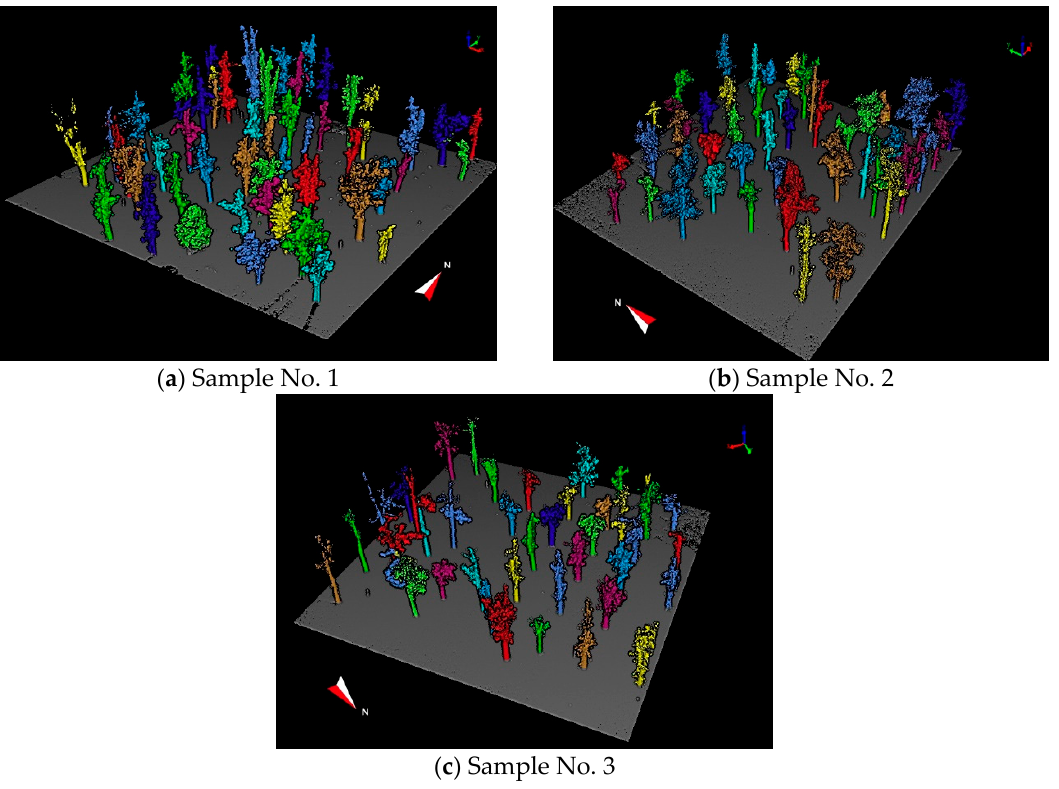
Figure 7. Display diagram of the single tree partition effect in the sample plots. ( a ), ( b ), and ( c ) represent the point cloud models of plots 1, 2, and 3, respectively, after the completion of the single-segmentation operation.